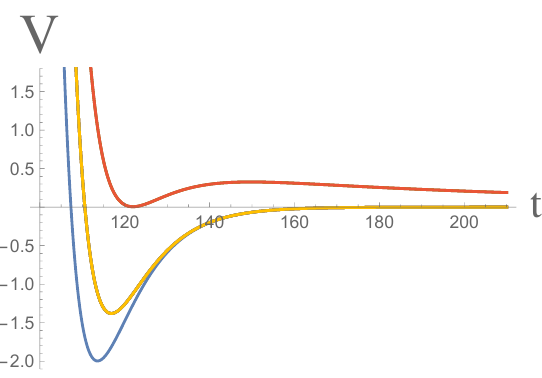
Figure 1 . The potential of the theory (3.7) (multiplied by 10 15 ) for A = 1, a = 0 : 1, W 0 = (cid:0) 10 (cid:0) 4 , 0 < (cid:12) (cid:28) 1. The blue (lower) line shows the potential with a supersymmetric AdS minimum prior to uplifting, at b = c = 0. The second (yellow), line shows the potential at b = 0 uplifted by increase of c to c = 1. Finally, the upper (red) line shows the potential with a dS (nearly Minkowski) minimum for c = 1, b = 10 (cid:0) 5 . The main part of the uplifting is not due to the large change of c from 0 to 1, but due to the tiny change of b from 0 to b = 10 (cid:0) 5